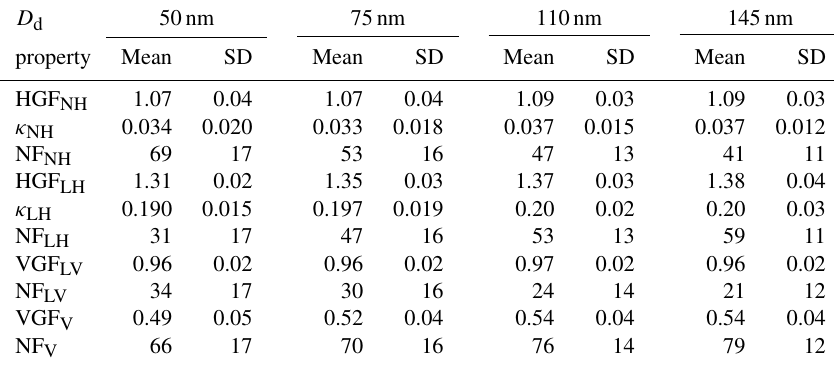
Table 1. Mean hygroscopic growth factor (HGF) and mean hygroscopicity parameter ( κ ) separately for nearly hydrophobic (NH) mode (HGF < 1.2) and less hygroscopic (LH) mode (1.45 > HGF ≥ 1.2) obtained for different dry particle diameters ( D d ) at a mean RH of 90%, and mean volatility growth factors (VGFs) separately for less volatile (LV) mode and for volatile (V) mode for different D d values at a mean denuding temperature of 270 ◦ C. Mean number fraction (NF, in %) with respect to the total particle number concentration and SD for each mode are also given. D d